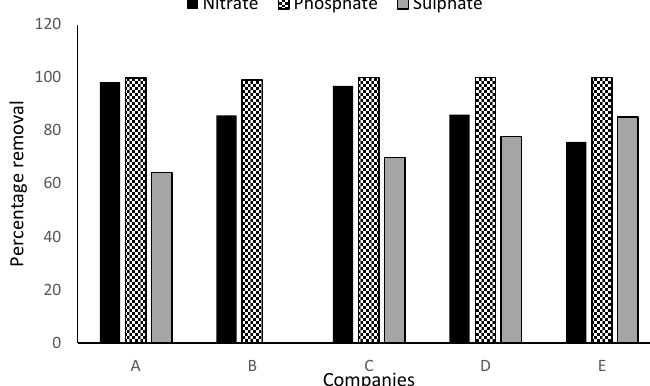
Figure 3. WWTP removal efficiencies of Companies A, B, C, D and E for Nitrate, phosphate and sulphate.